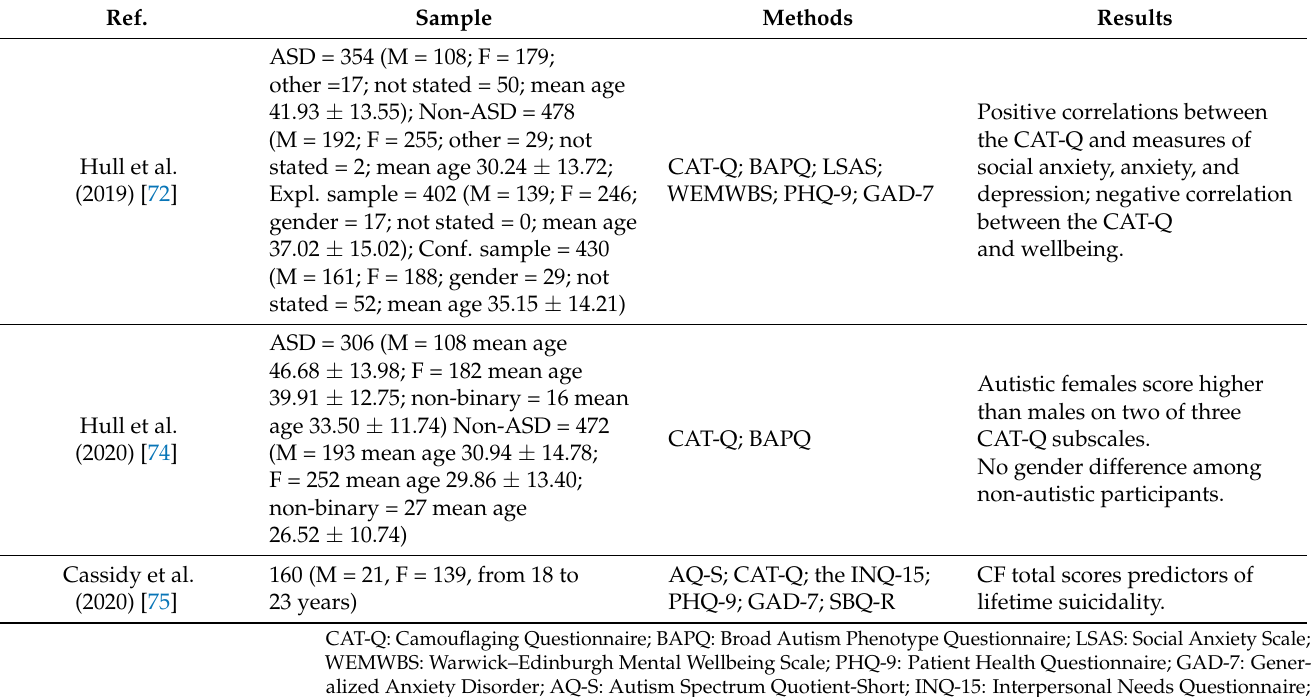
Table 3. The available literature on Social Camouflaging (Part 3).